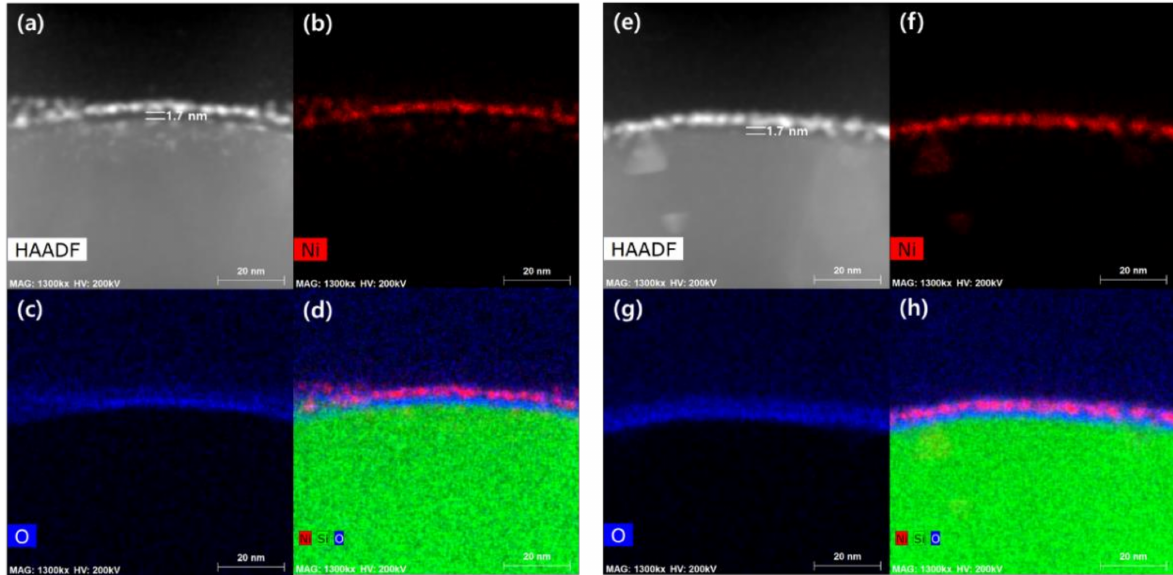
Figure 6. Comparison of NiO x layer on n + poly-Si: ( a ) with annealing; ( e ) without annealing; ( a , e ) scanning transmission electron microscopy (STEM) images; ( b – d , f – h ) energy dispersive spectroscopy (EDS) mapping